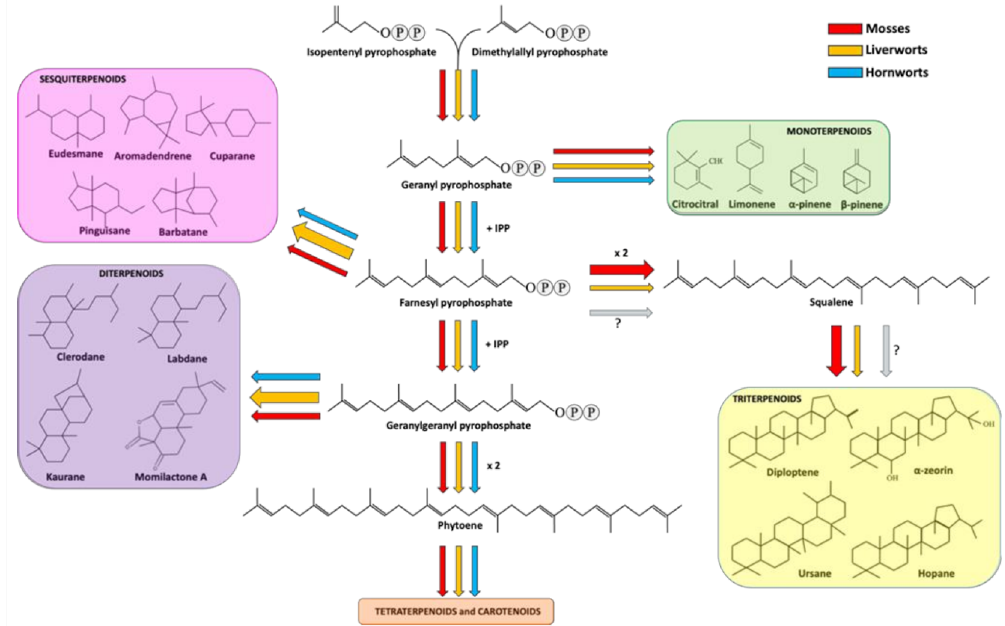
Figure 1. Terpenoid biosynthetic pathway in bryophytes. Red, orange and cyan arrows indicate the metabolic fluxes observed in mosses, liverworts and hornworts, as suggested in various reports (see references in the main text). Arrow thickness represents the amount of carbon streams (resources) committed for the production of specific metabolites in a specific bryophyte division. The question marks next to the faint arrows state that no information is available about the production of squalene and triterpenoid in